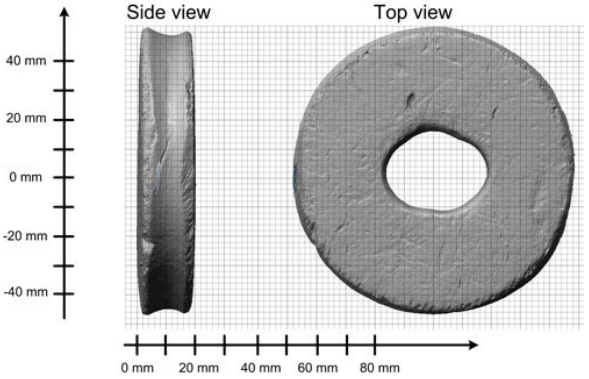
Figure 8. 3D model of a wooden pulley.